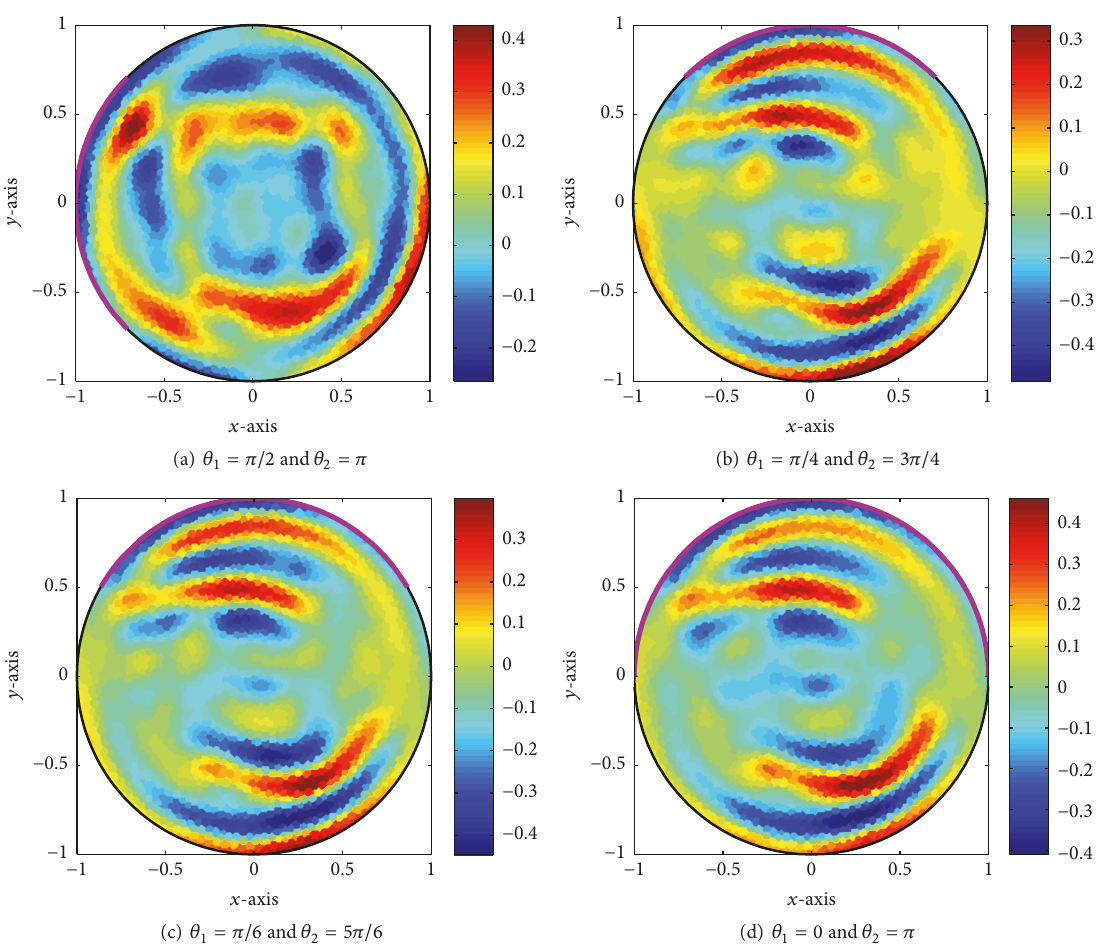
Figure 7: Maps of E ( z ;𝐹) for Γ 2 ∪ Γ 3 . Violet-colored solid line describes the range of incident